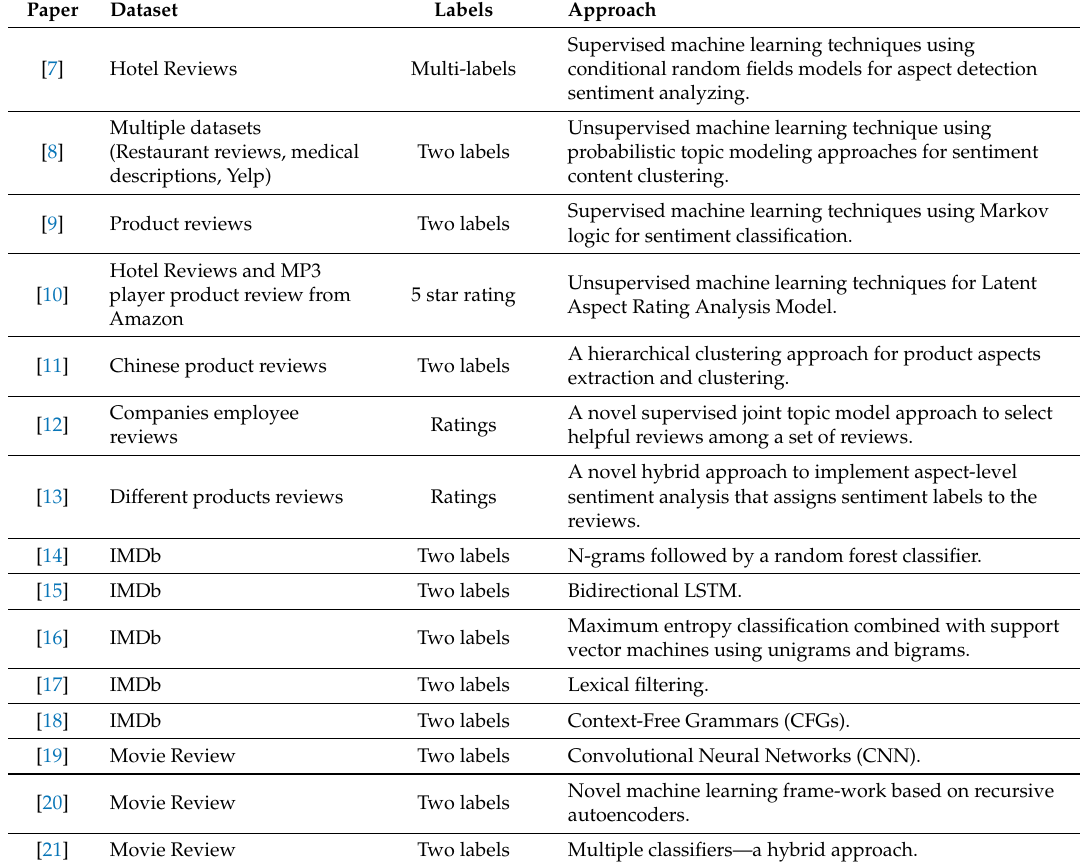
Table 1. A summary of the state-of-the-art approaches for sentiment